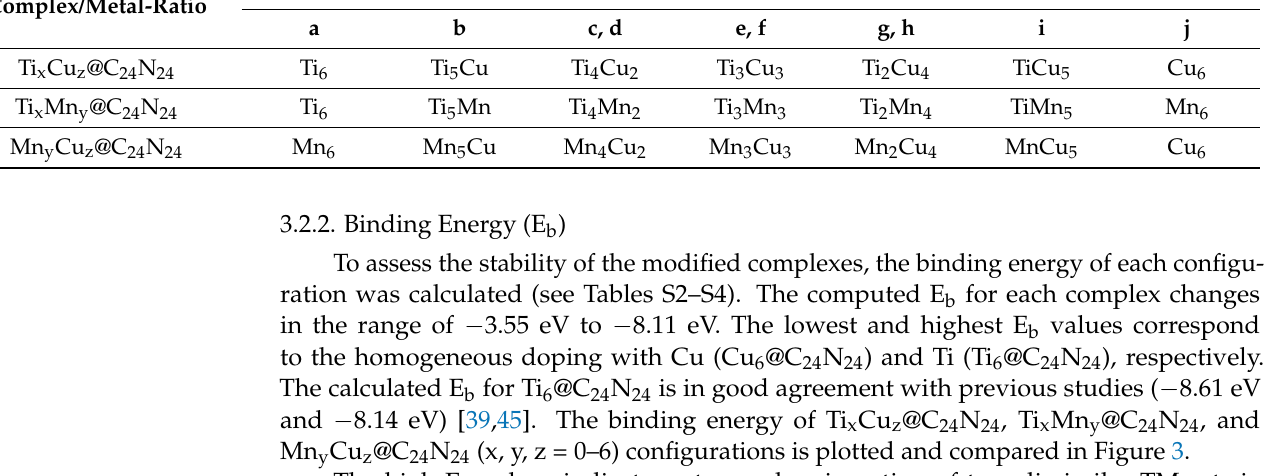
Figure 2. A schematic representative of possible distribution patterns of two dissimilar TMs (TM 1 :TM 2 ) in N 4 -pyridinic cavities of the C 24 N 24 nanocage: ( a ) 6:0, ( b ) 5:1, ( c , d ) 4:2, ( e , f ) 3:3, ( g , h ) 2:4, ( i ) 1:5, ( j ) 0:6.Color code: white, Ti; orange, Cu. Table 1. Distribution patterns of bi-metal atoms in C 24 N 24 cavities.